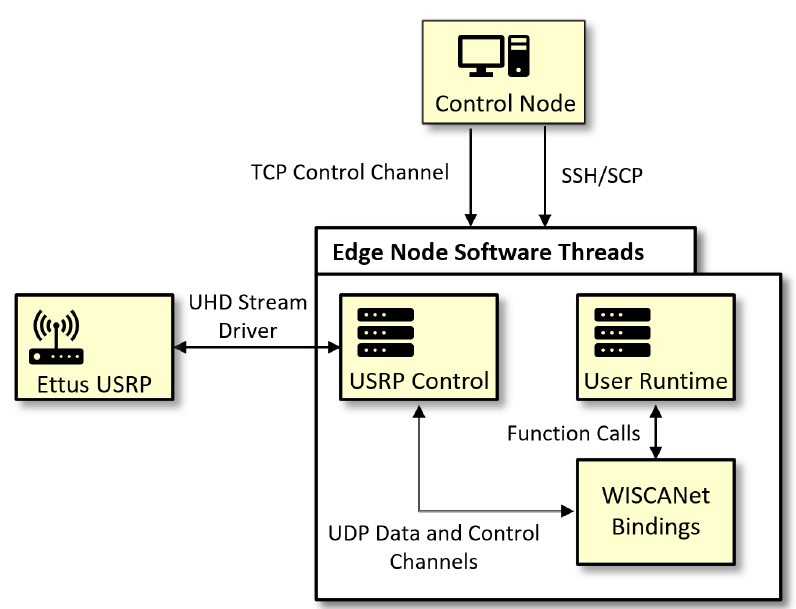
Figure 3. Example interactions between a control node, edge node, and Ettus radio